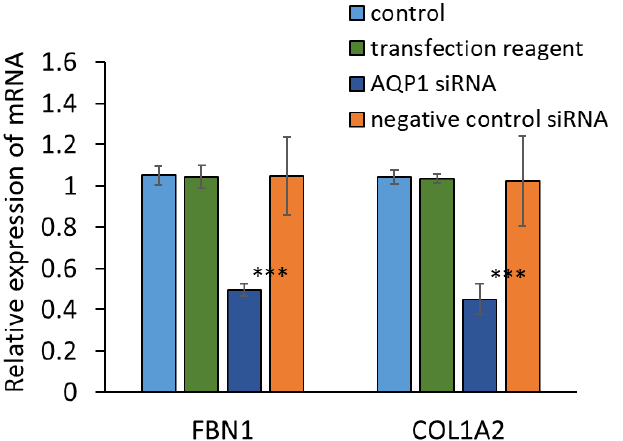
Figure 7. mRNA expression levels in cultured human dermal fibroblasts after AQP1 depletion for 2 days by AQP1 siRNA. ***: p < 0.001 vs. the transfection reagent. The figure shows the means ± standard deviations ( n = 3).